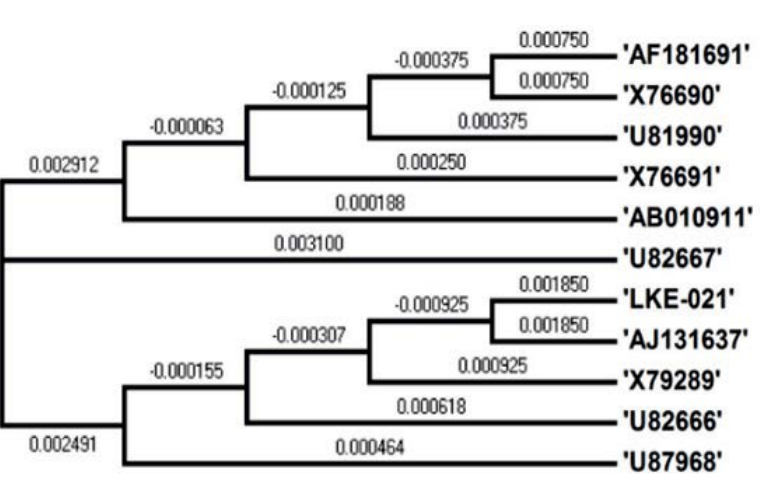
Table 2. Nucleotide distance (below diagonal) and similarity (above diagonal) identities among the studied sample ‘LKE-021’ and ten other closest homologs microorganism indicates in Table